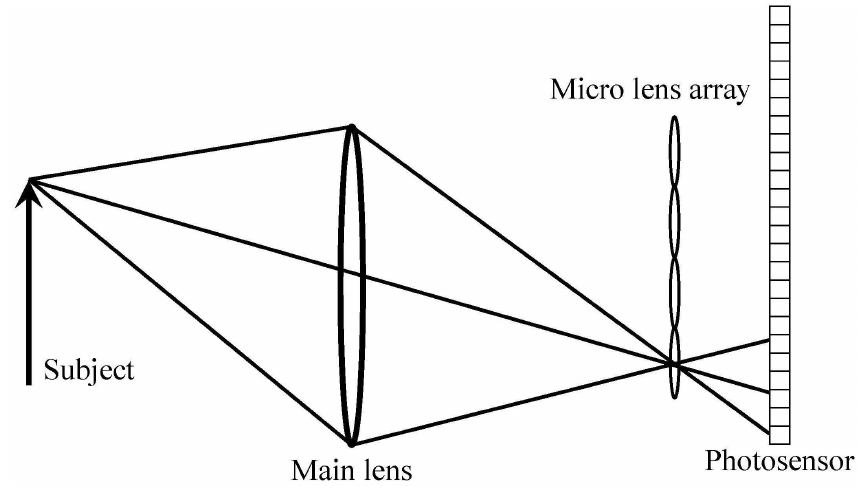
Figure 2. Schematic diagram of light field camera